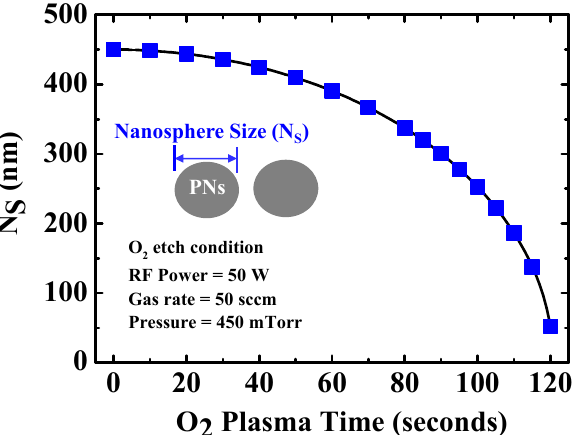
Figure 2. Size of the polystyrene nanosphere as a function of O 2 plasma exposure time.